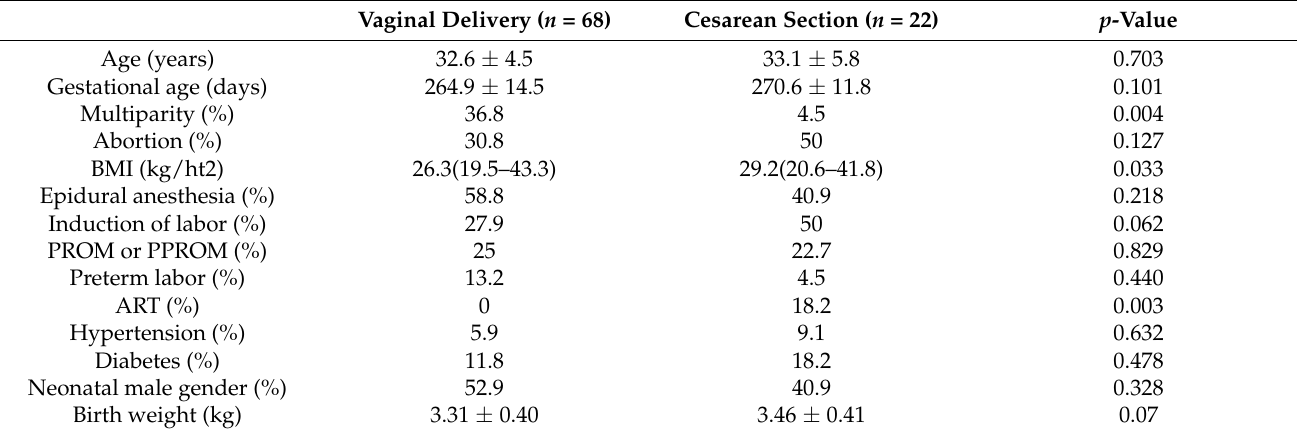
Figure 2. Flowchart of study population. Table 1. Patient characteristics according to mode of delivery.